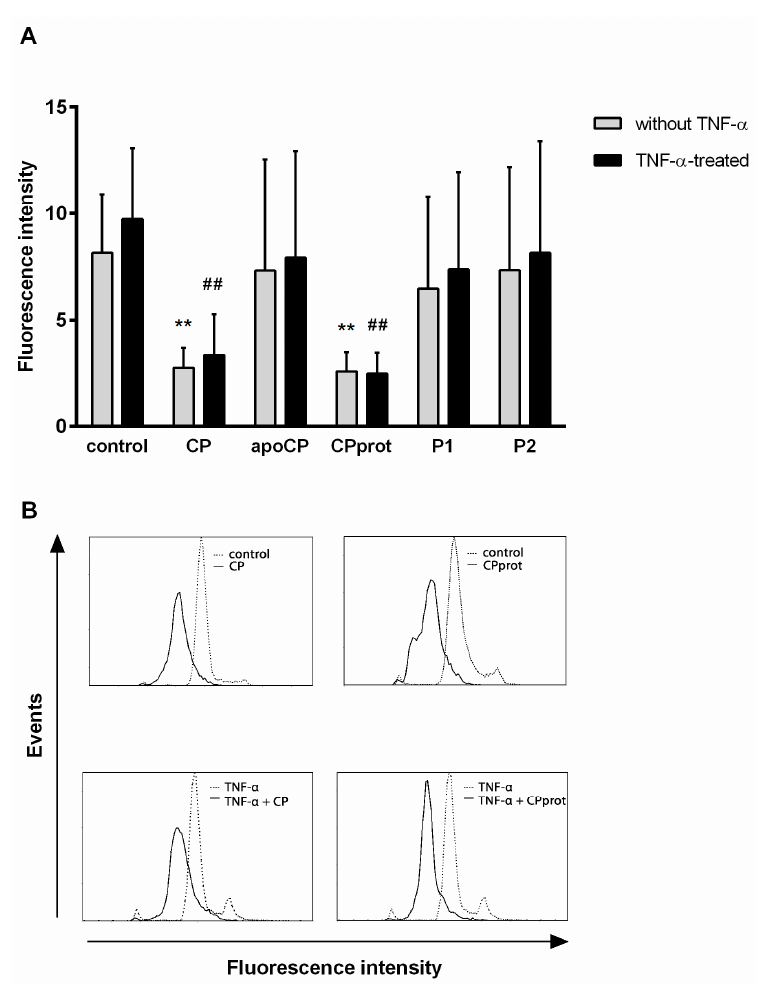
Figure 2. Effects of ceruloplasmin (CP) and its derivatives on intracellular superoxide generation by neutrophils. Dihydroethidium (DHE)-stained polymorphonuclear leukocytes (PMNLs) were cultured with 0.5 µM CP, 0.5 µM apo-CP, 0.5 µM proteolyzed CP (CPprot), or 20 µM peptides (P1 or P2), with or without 25 ng/mL TNF- α for 60 min at 37 °C, which was followed by flow cytometric measurements of red fluorescence. ( A ) Values represent the means ± SEM of fluorescence intensities, arbitrary units of duplicate cultures from four independent experiments; **, ## p < 0.01, compared to the control (medium) and TNF- α -treated PMNLs, respectively (one-way ANOVA followed by Holm–Šídák multiple comparison tests). ( B ) Representative histograms of PMNL distribution according to accumulation of DHE oxidation products.